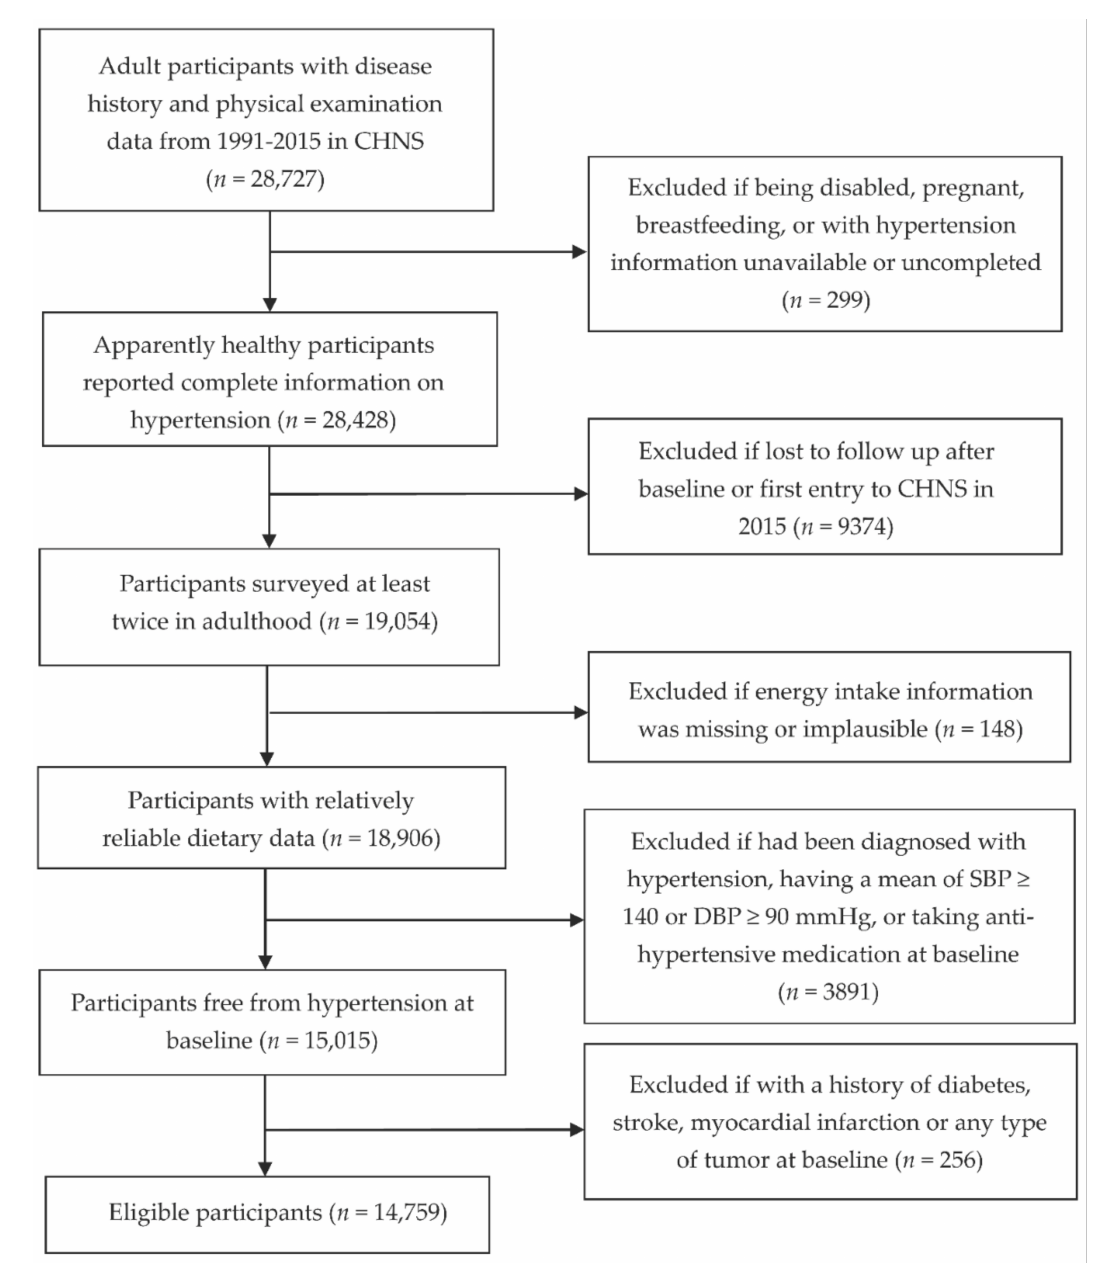
Figure 1. Flow chart of participant